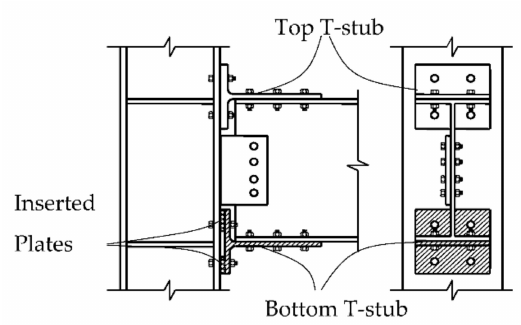
Figure 1. Configuration of new T-stub connections with inserted